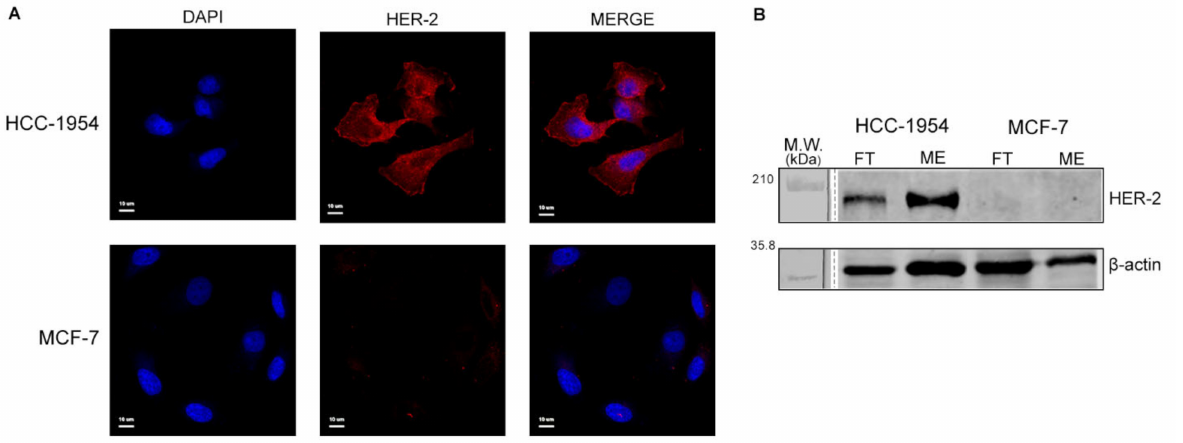
Figure 1. HER-2 protein expression analysis in HCC-1954 and MCF-7 cell lines. ( A ) Immunofluores- cence of HER-2 in HCC-1954 and in MCF-7 cell lines. ( B ) Western blot of HER-2 in total extract (TE), flow-through (FT) and membrane-enriched (ME) fractions of HCC-1954 and MCF-7 cell lines. Raw data of Western blot membrane are shown in Supplementary Figure